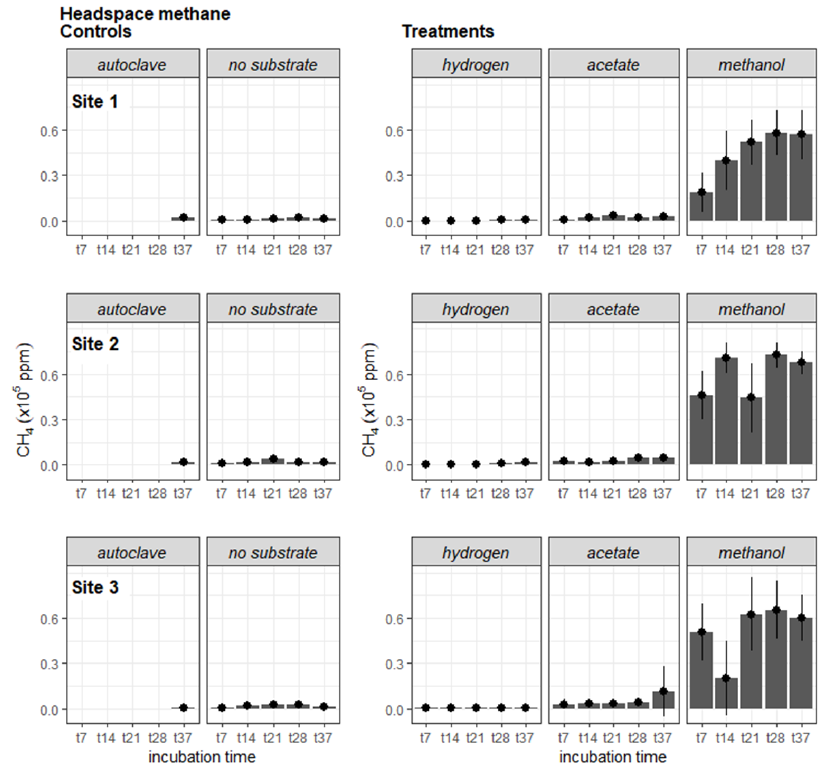
Figure 4. CH 4 concentrations in the bottle headspace following the sampling times. Incubation times (t7–t37) denote sampling times from Day 7 to Day 37 on Days 7, 14, 21, 28, and 37 of incubation. Controls and treatments indicated at the top of each panel. The values are the average of two replicates and five depths and error bars represent 1 standard deviation.